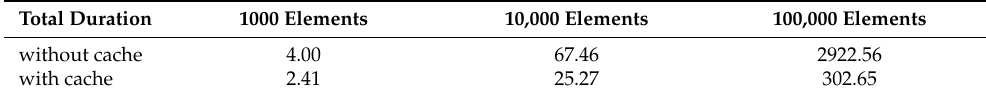
Table 5. Total duration of shared index update process duration with and with no cache (in